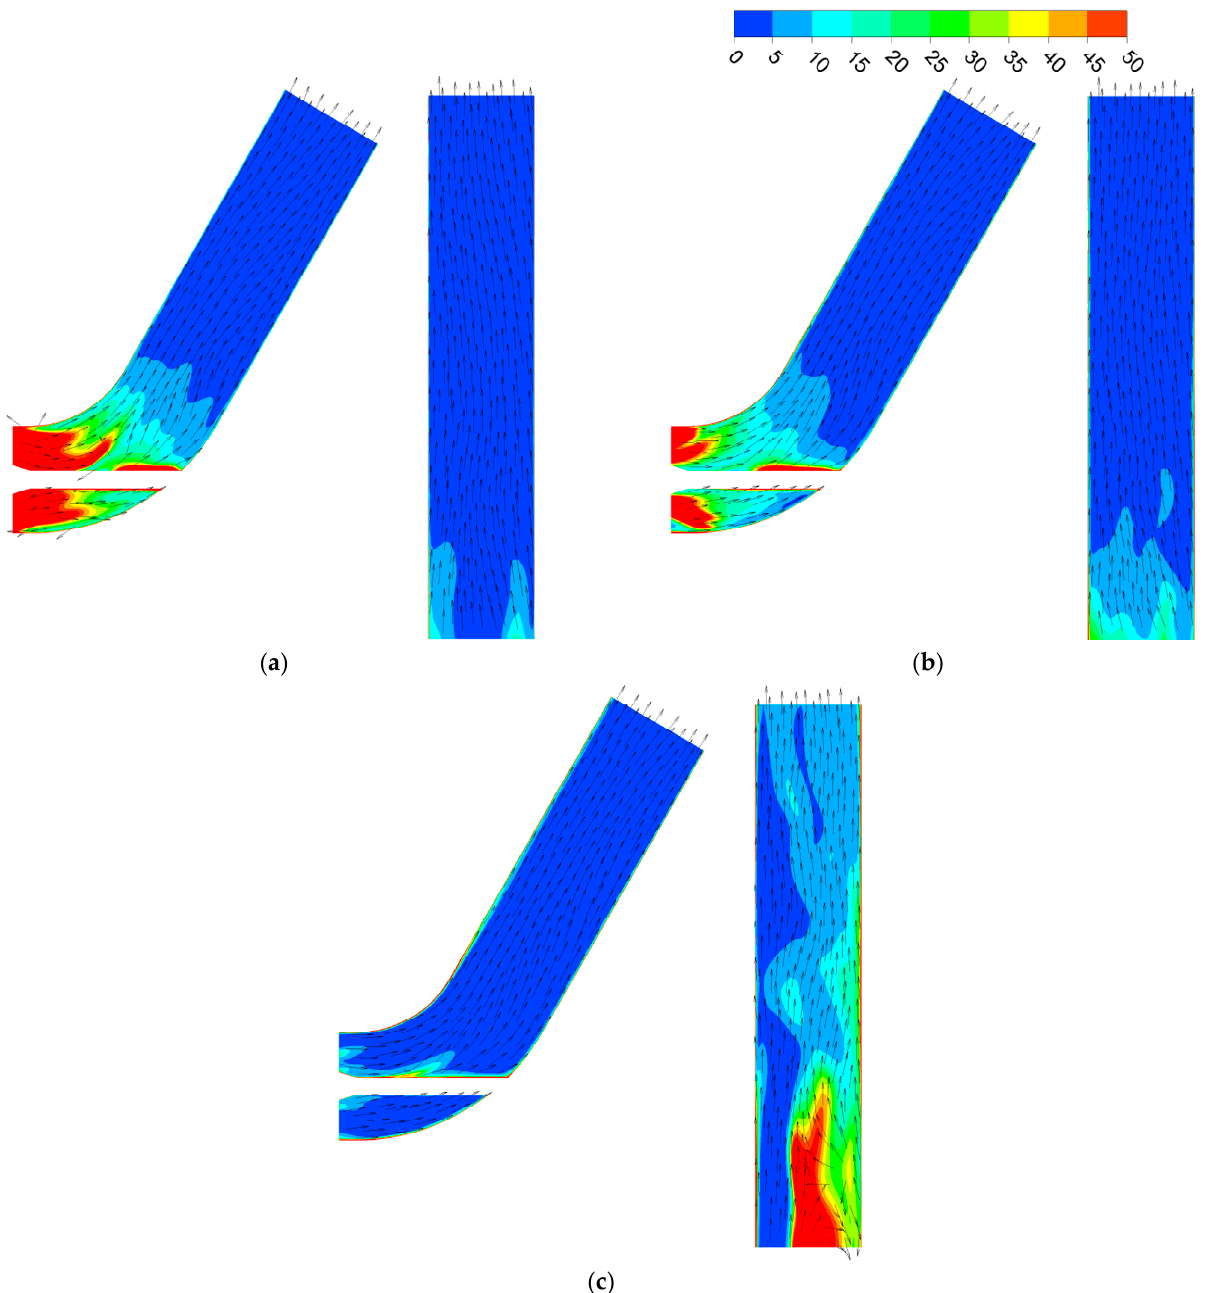
Figure 17. The distribution of TEPR and velocity in the section of the outlet pipe under the guide vanes and volute scheme at ( a ) 800 m 3 /s, ( b ) 1200 m 3 /s and ( c ) 1600 m 3 /s.